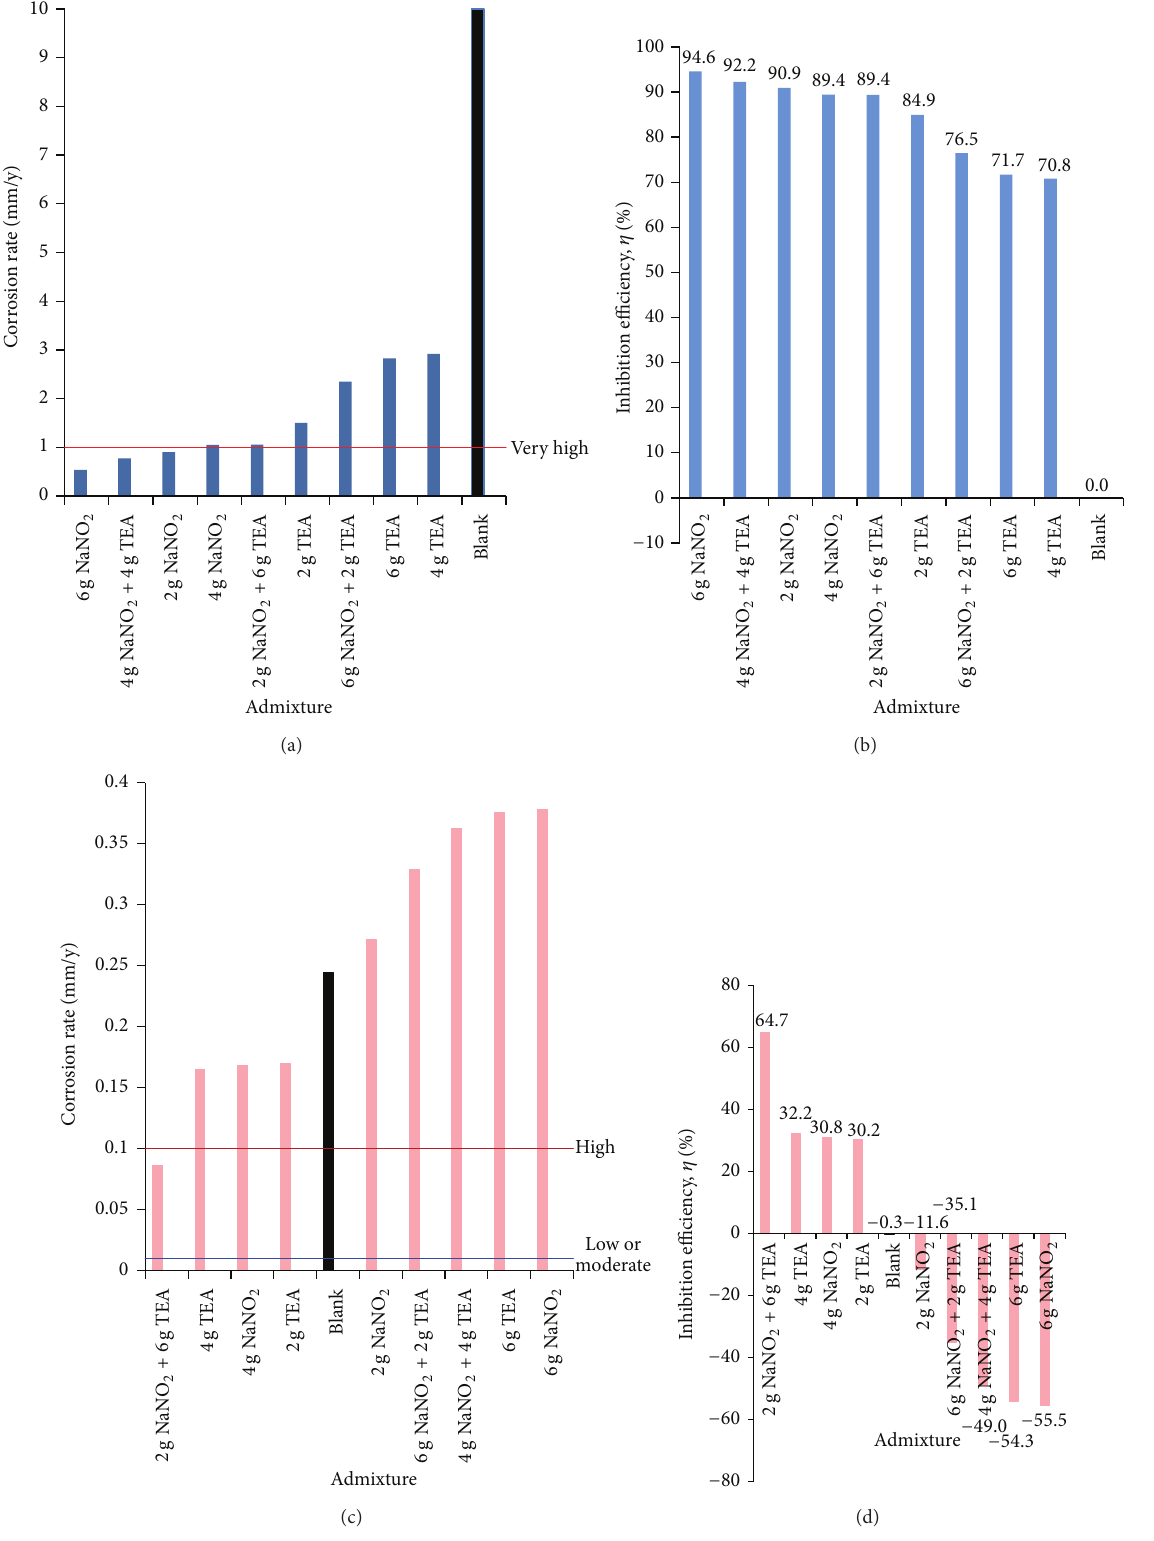
Figure 4: Performance effectiveness ranking of admixtures at inhibiting concrete steel-rebar corrosion in concrete immersed in aggressive media for ninety-six days of experimental period: (a) corrosion rate ranking in NaCl medium, (b) inhibition efficiency ranking in NaCl medium, (c) corrosion rate ranking in H 2 SO 4 medium, and (d) inhibition efficiency ranking in H 2 SO 4